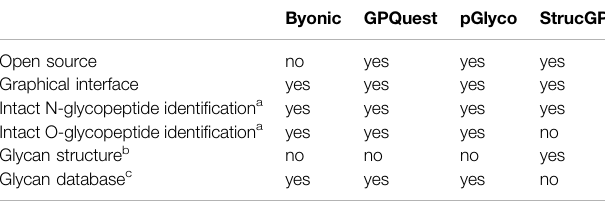
TABLE 1 | Major characteristics of different glycoproteomic search engines. Byonic GPQuest pGlyco StrucGP